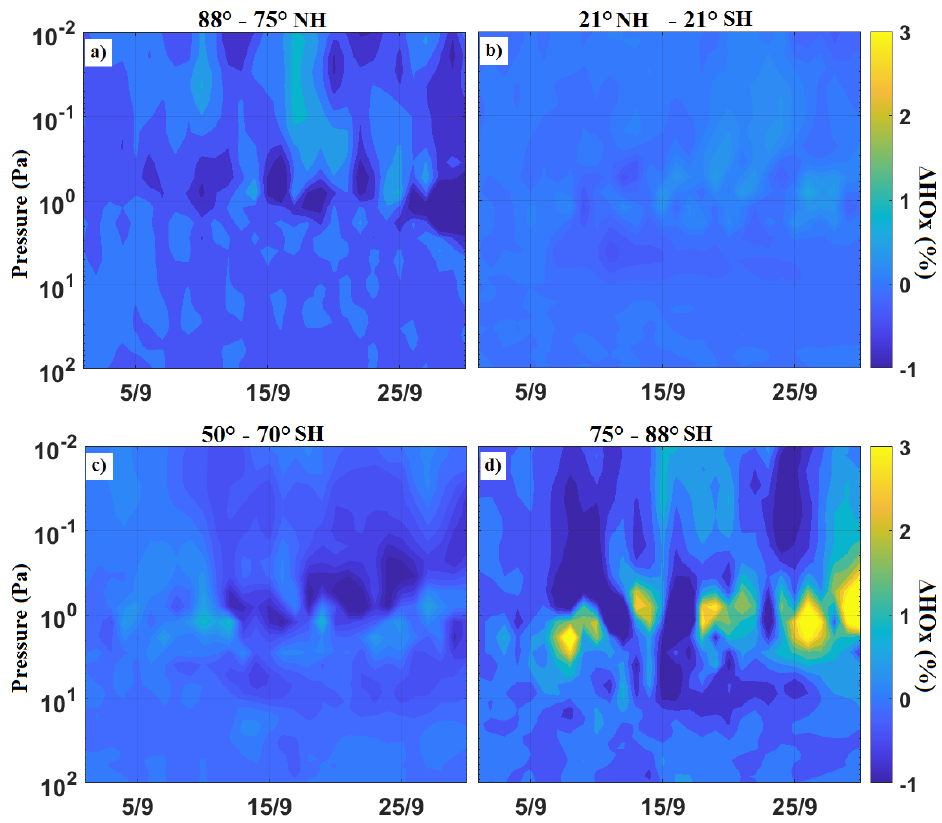
Figure 3. The response of the hydrogen group HO x (H, HO, HO 2 ) to solar flares X9.3 on 6 September and X8.2 on 10 September 2017 in the regions of northern polar latitudes ( a ), equatorial latitudes ( b ), southern latitudes ( c ), south polar latitudes ( d